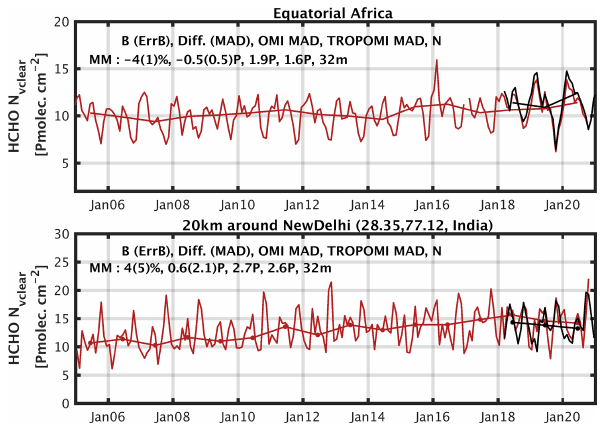
Figure 6. Examples of monthly and yearly averaged HCHO columns ( N v_clear ) retrieved from OMI (October 2004– in black) at two different spatial scales selected for the com- parison: a large region of equatorial Africa and a circle of 20km radius over New Delhi in India. Absolute and relative biases between OMI and TROPOMI HCHO monthly averaged columns are given at the top of each panel as are the me- dian deviations of the OMI and TROPOMI averaged columns. (Pmolec.cm − 2 = 1 × 10 15 molec.cm − 2